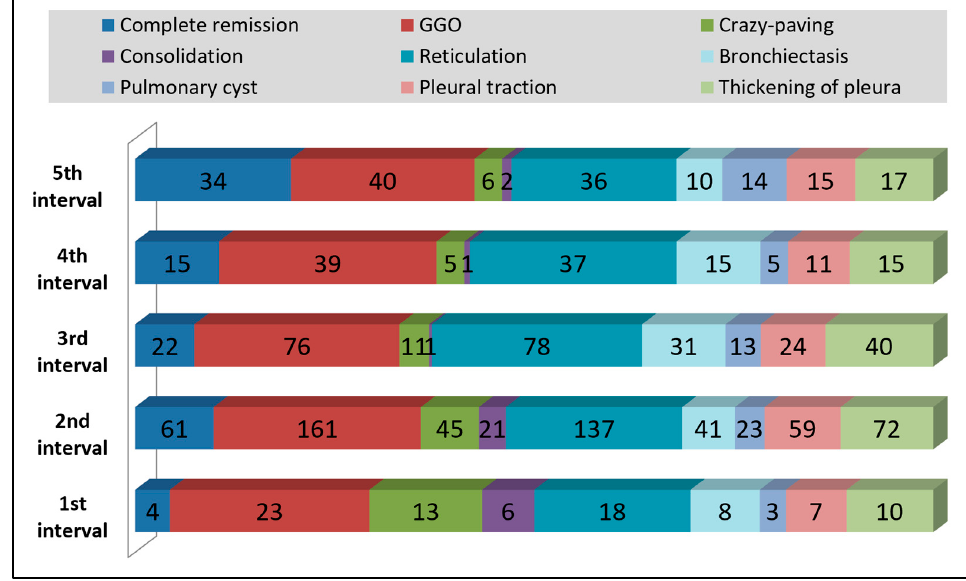
Figure 5. Evolution of HRCT findings by frequency in all patients included in the study.